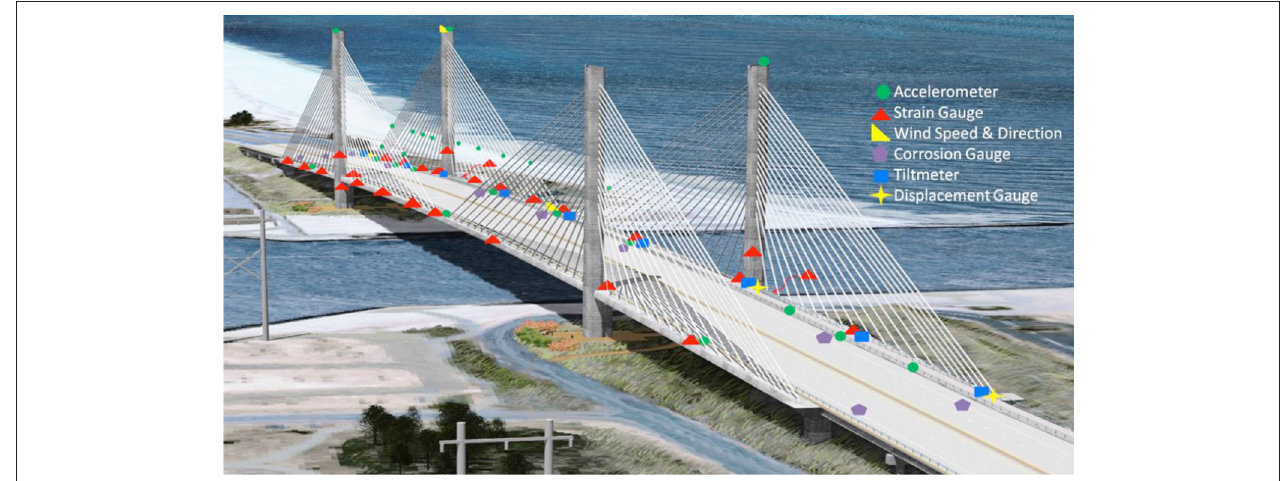
FIGURE 1 | Layout of sensors in the SHM